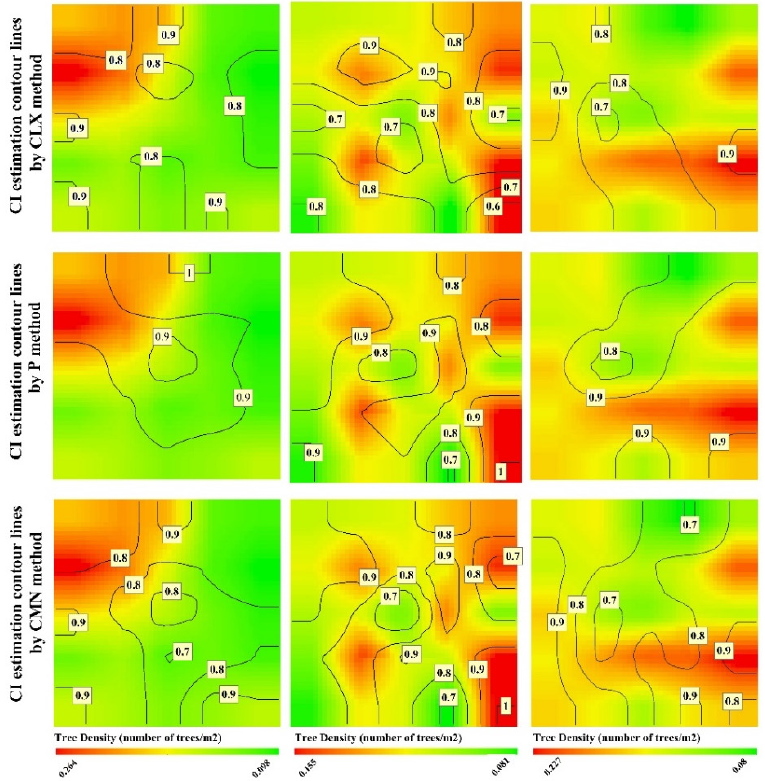
Figure 8. The spatial distribution of CI estimation using different methods in the plot (note: the contour lines show the CI estimation using various methods).